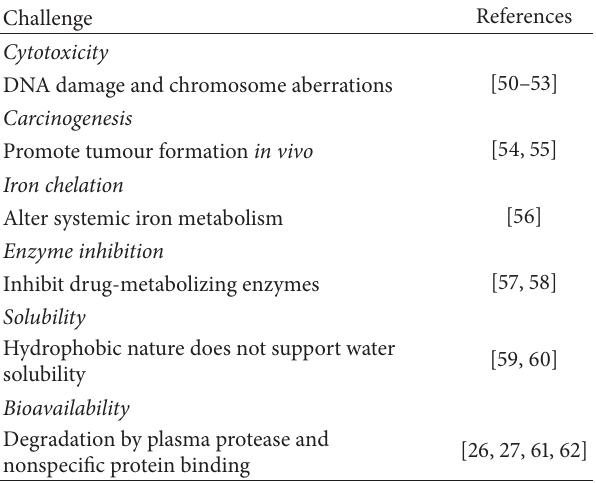
Table 3: Challenges of curcumin use in clinical